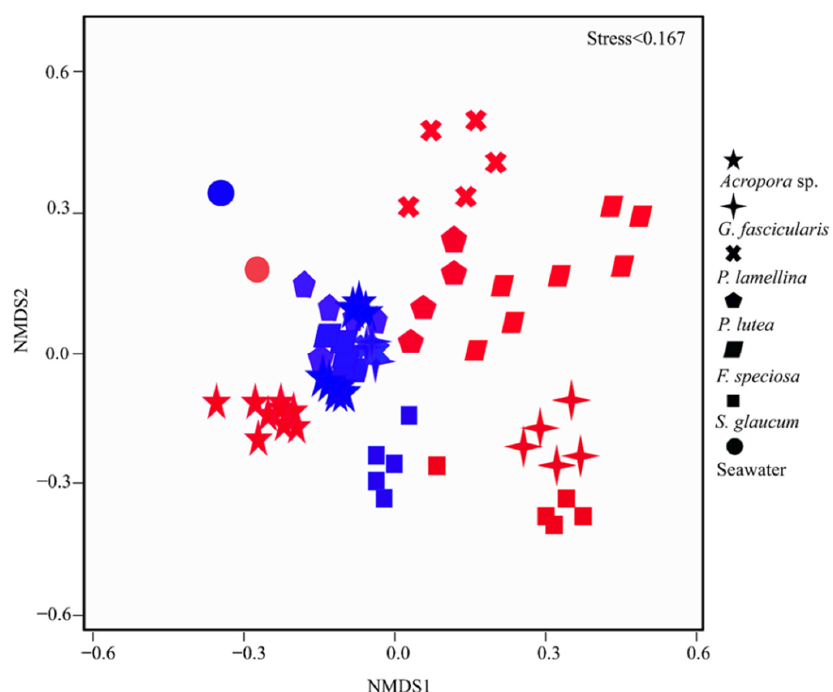
Figure 2. Non-metric multidimensional scaling (NMDS) ordination of coral microbiome assemblages based on Bray–Curtis distance. Different symbols represent different coral species (the names of different coral species and corresponding symbols were illustrated on the right of the NMDS ordination plot). The solid cycle represents seawater. Red symbols indicate samples from the SY reef, and blue symbols represent samples from the DY reef.